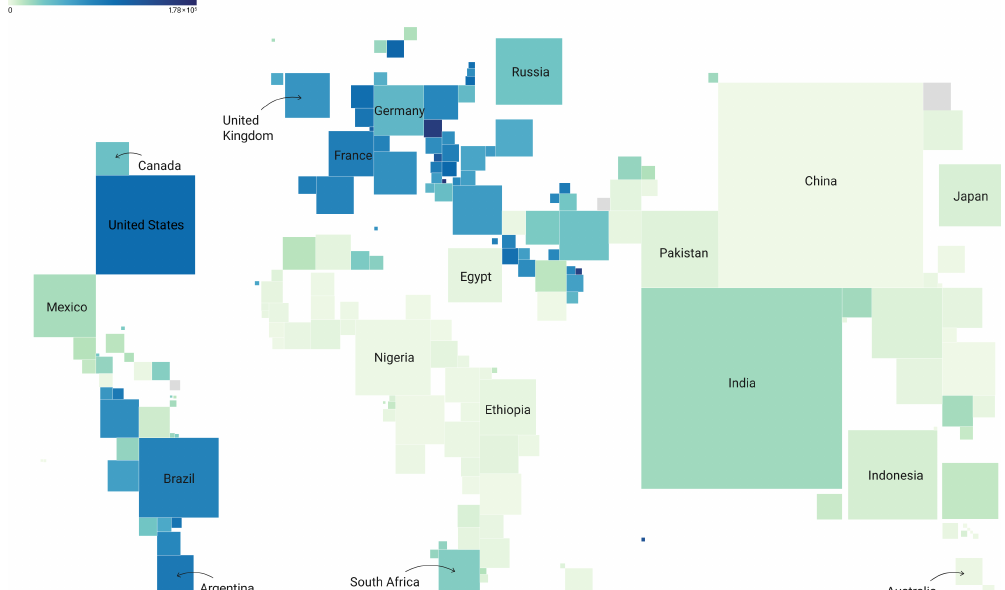
Fig. 1 Cumulative confirmed COVID-19 cases per million on June 10, 2021. Darker colors indicate higher numbers of confirmed cases per million. The bigger the country or region’s population, the bigger the square. The number of confirmed cases is lower than that of actual cases, mainly due to limited testing.